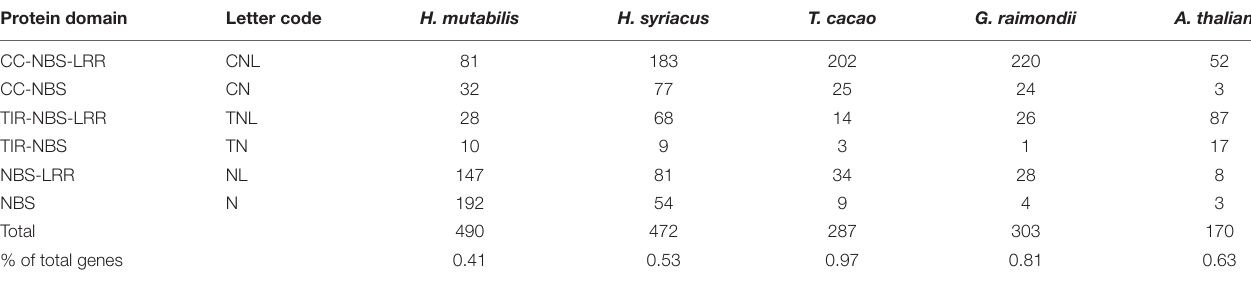
TABLE 2 | Numbers and classifications of genes encoding NBS-containing resistance proteins in five plant species. Protein